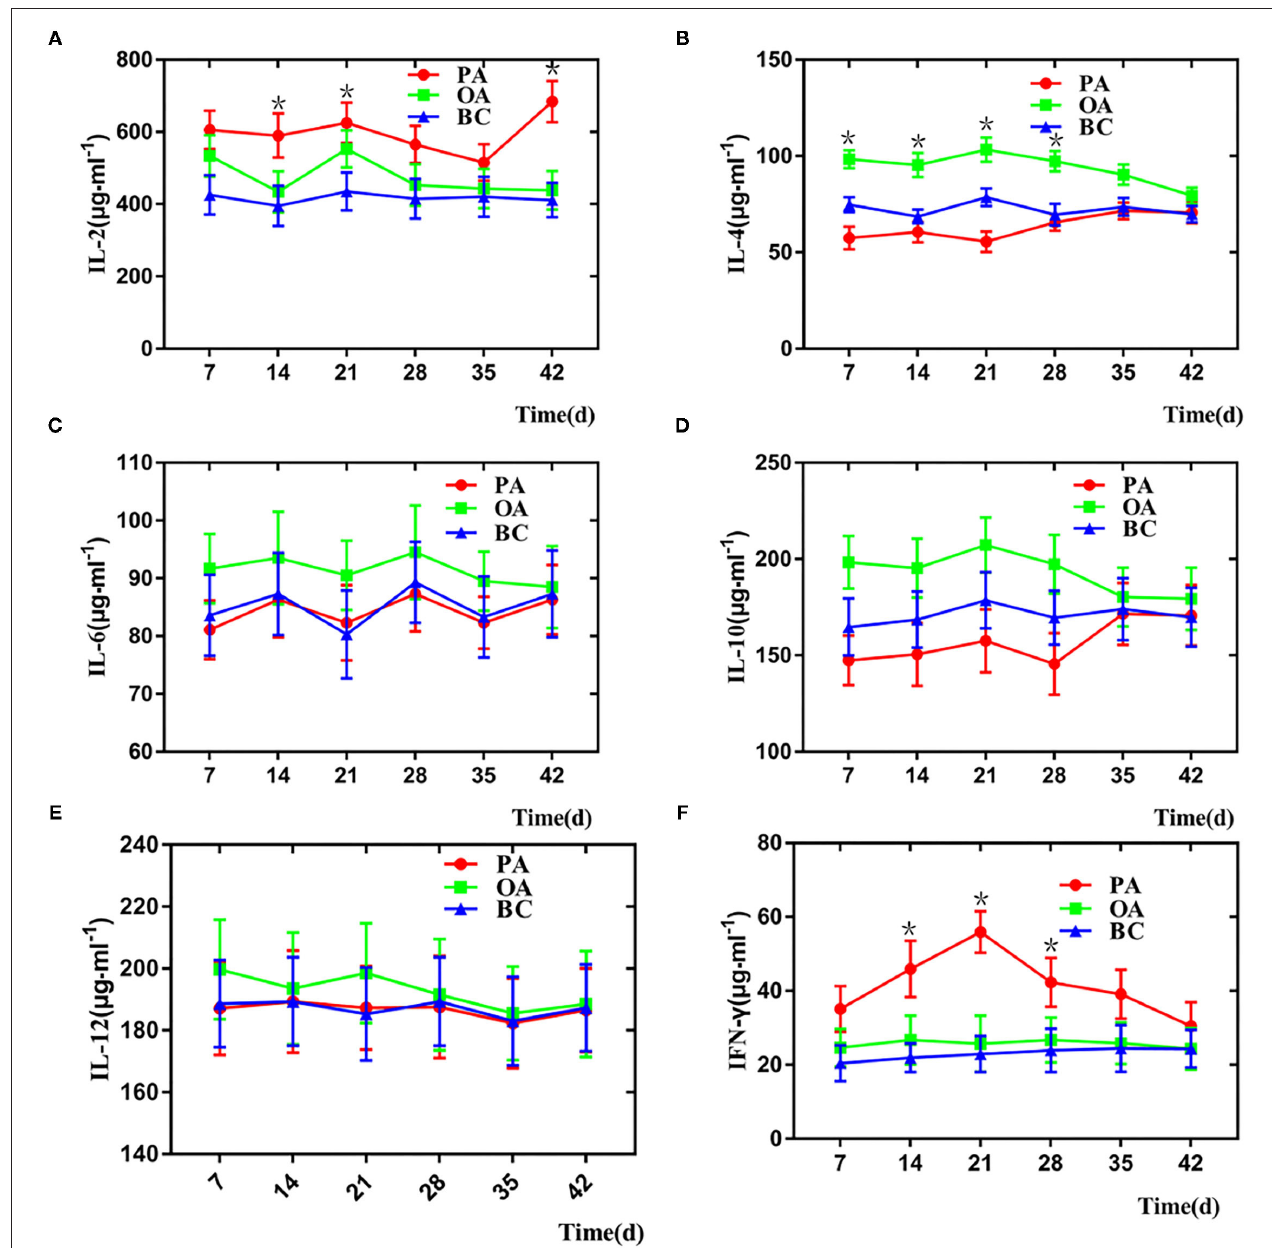
FIGURE 4 | Change of serum cytokine in each group. (A) IL-2, (B) IL-4, (C) IL-6, (D) IL-10, (E) IL-12, and (F) IFN- γ . *There is a significant difference compared with BC